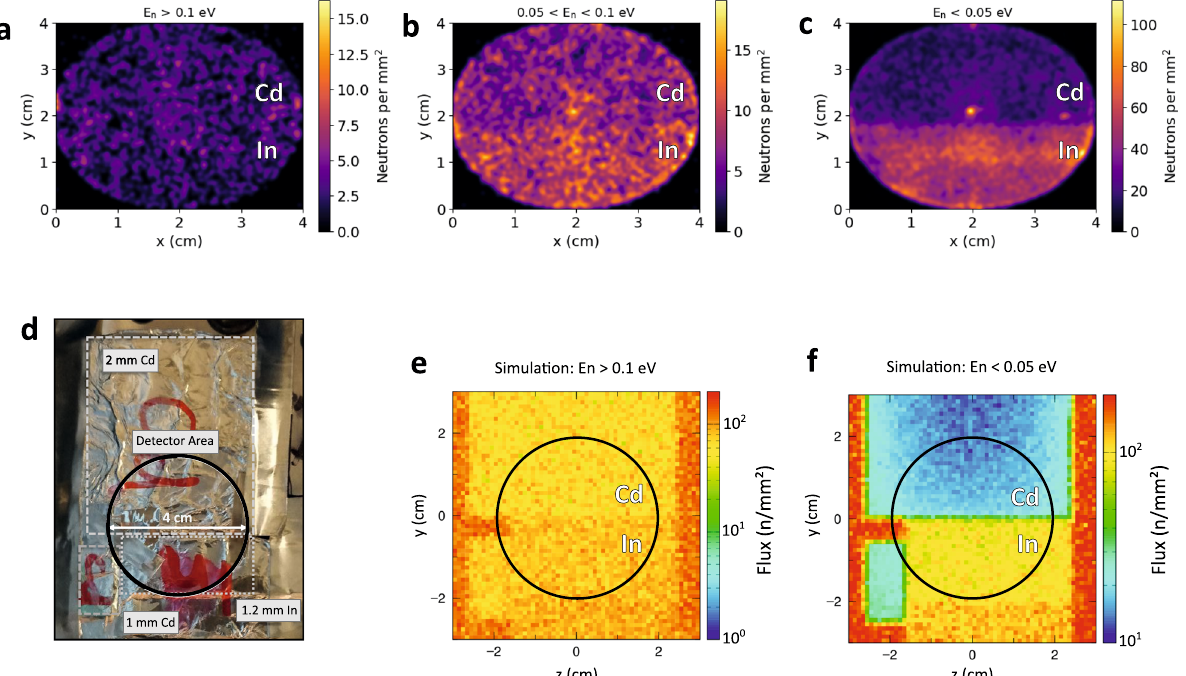
Fig. 6 Neutron resonance imaging (NRI) with a LDNS. a – c Spatial distribution of detected neutron events for the NRI measurement. a The MCP detector signal shows all non-resonant neutron events with arrival times corresponding to energies > 0.1 eV. b The MCP detector signal shows events attributed to neutron energies between 0.05 and 0.1 eV. An increased absorption behind the 2-mm cadmium sheet is visible. c shows the distribution of neutron events with energies below 0.05 eV. A strong attenuation is visible behind the cadmium sheet and a small attenuation is observed behind the indium sample. d Sample distribution in front of the borated MCP detector. The active detector area has a diameter of 4 cm (black circle). The upper half is covered with 2-mm thick Cd and the lower half with 1.2-mm thick In (dashed white rectangles). e , f PHITS simulations for ( a , c ). The simulation ( e ) predicts 76 ± 5 n/ cm 2 behind Cd and 94 ± 4 n/cm 2 behind In. f predicts 16 ± 1 n/cm 2 behind Cd and 111 ± 6 n/cm 2 behind In.